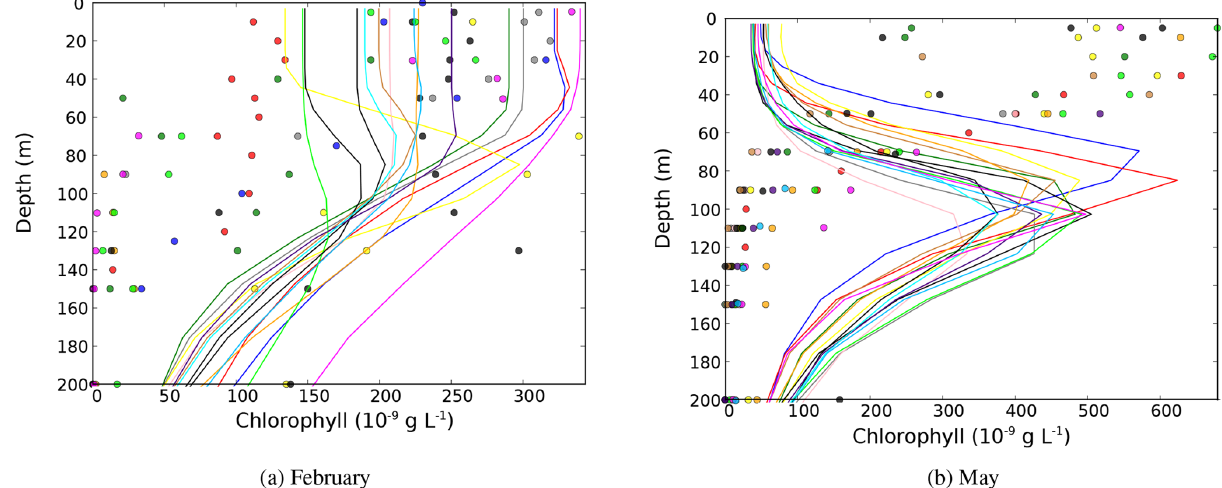
Figure A1. Average Chl a profiles in February (a) and May (b) for the years 1991 to 2005 at the DYFAMED station in the Ligurian Sea (43.4277 ◦ N, 7.2522 ◦ E). Dots represent data points (Marty et al., 2002; Faugeras et al., 2003). Lines represent the HIS/A2 simulation. Colors represent individual